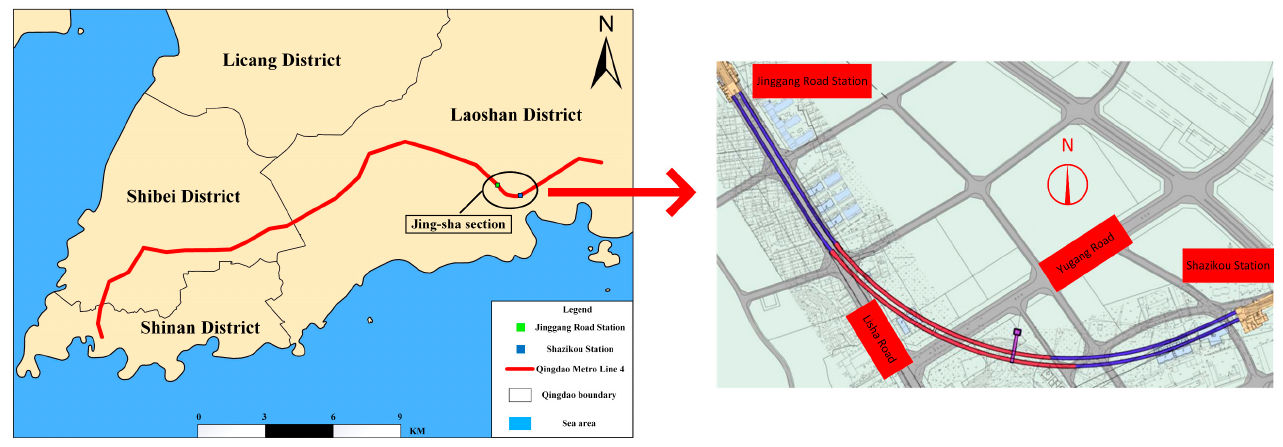
Figure 1. The location of Jing-sha